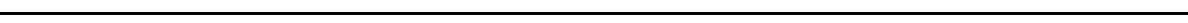
Fig. 9 NbBeclin1 targets RdRps of plant viruses distinct to potyviruses and inhibits viral infection. a , b Schematic representation of the full-length CGMMV RdRp ( a ) and PepMV RdRp ( b ). The positions of the fi rst and last amino acid residues of each conserved domain are indicated. Met methyltransferase domain, Hel helicase domain, RdRp2 RdRp2 domain. c NbBeclin1 interacts with CGMMV (CG) and PepMV (PE) RdRps or their RdRp2 domains but not with their GDD mutants or other domains, i.e., Met and Hel in the Y2H assays. d Co-IP analysis of possible interactions of NbBeclin1 with different domains or the GDD mutant of CGMMV and PepMV RdRps in planta. N . benthamiana leaves were agroin fi ltrated with the plasmids indicated. Leaf extracts were incubated with GFP- Trap ® _MA magnetic agarose beads (ChromoTek). Samples before (Input) and after (IP) immunopuri fi cation were analyzed by immunoblotting using GFP or Myc antibody. Yellow asterisks indicate the expected band sizes. e BiFC assays for the interaction of NbBeclin1 with different domains of CGMMV RdRp or PepMV RdRp in H2B-RFP transgenic N . benthamiana leaves at 48hpi. Bars = 50 μ m. f Quanti fi cation of CGMMV or PepMV RNA levels by qRT-PCR. The plants were pre-inoculated with buffer (mock), TRV1 + TRV2-GUS, or TRV1 + TRV2-NbBeclin1 for 7 days. RNA was extracted from CGMMV or PepMV – inoculated or systemically infected leaves at 3dpi and 14dpi, respectively. The values are presented as means of fold change ±SD relative to mock-treated plants. Error bars represent SD. Three independent experiments, each consisting of three biological replicates, were carried out. Values from one representative result were used to plot a histogram and were normalized with NbActin as the internal reference. The data were analyzed using Student ’ s t -test and double asterisks denote signi fi cant differences compared to the CGMMV- or PepMV-infected NbBeclin1-silenced plants from control plants pretreated with mock (two-sided, ** P < 0.01). g , h Symptoms of CGMMV ( g ) or PepMV ( h ) infected plants at 21dpi. The plants were pre-inoculated with buffer (mock), TRV-GUS, or TRV-NbBeclin1 for 7 days. Mock inoculated with buffer, CGMMV inoculated with CGMMV, PepMV inoculated with